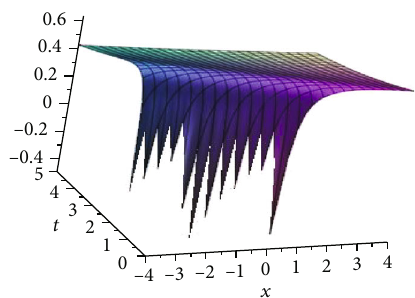
Figure 2: 3D plot of solution (15) of PDE (1).